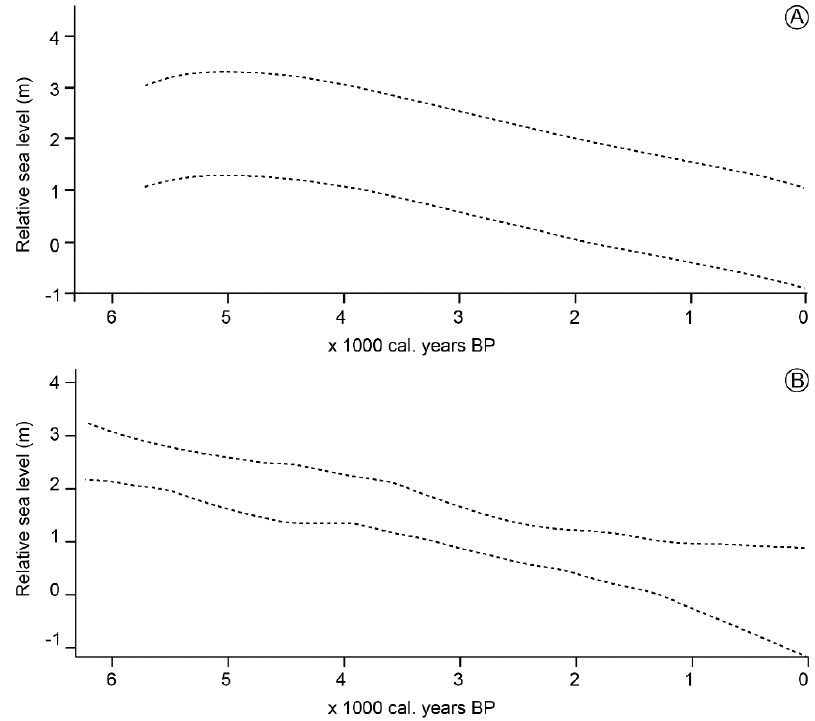
Figure 2. ( A ) Sea-level envelope for the Brazilian coast south of 28° S (modified after [4]); ( B ) Sea-level envelope for the Uruguayan coast (modified after [31]).